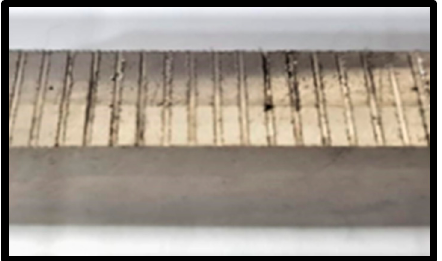
Figure 2. Milled workpiece having slot spacing of 2 mm.